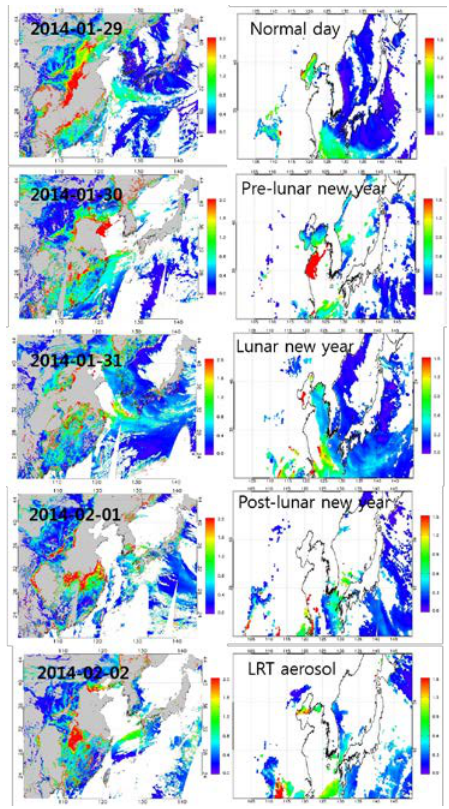
Figure. 1. Spatio-temporal distribution of Terra MODIS MSATR AOD (left) L2 AOD (right) over Northeast Asia during Lunar New Year period in 2014